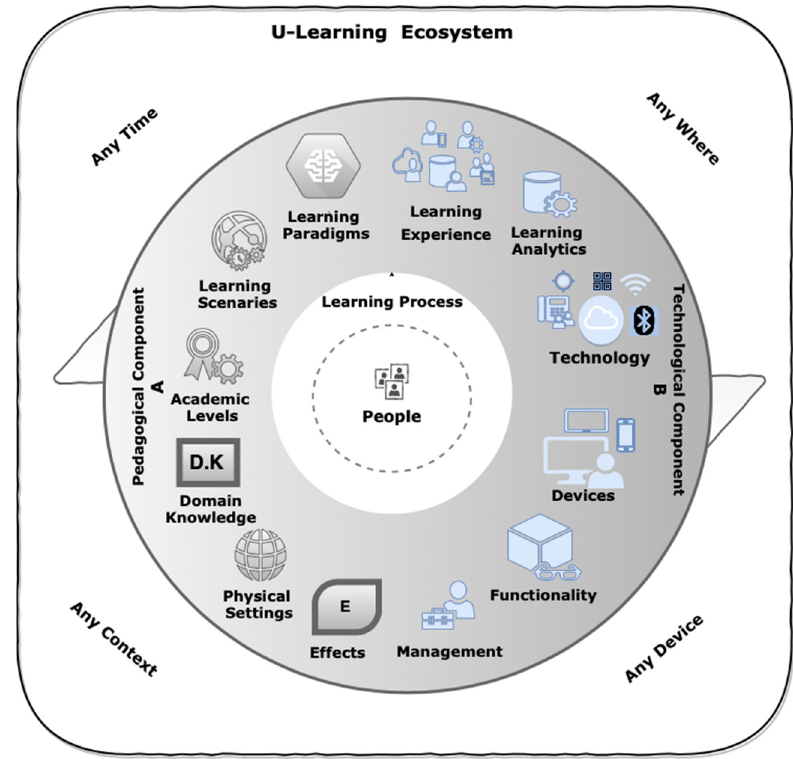
Figure 4. U-CLX Model Specific View [2].